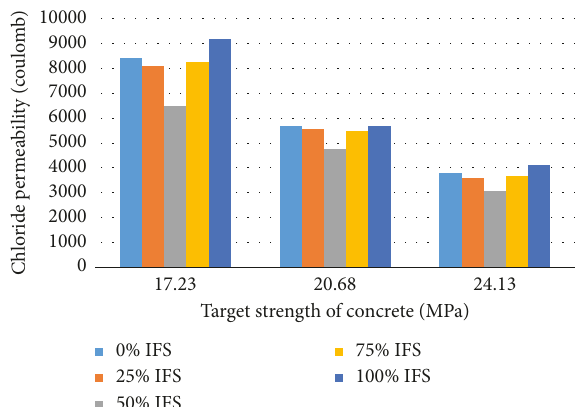
Figure 24: Chloride permeability of concrete for different target strengths and IFS